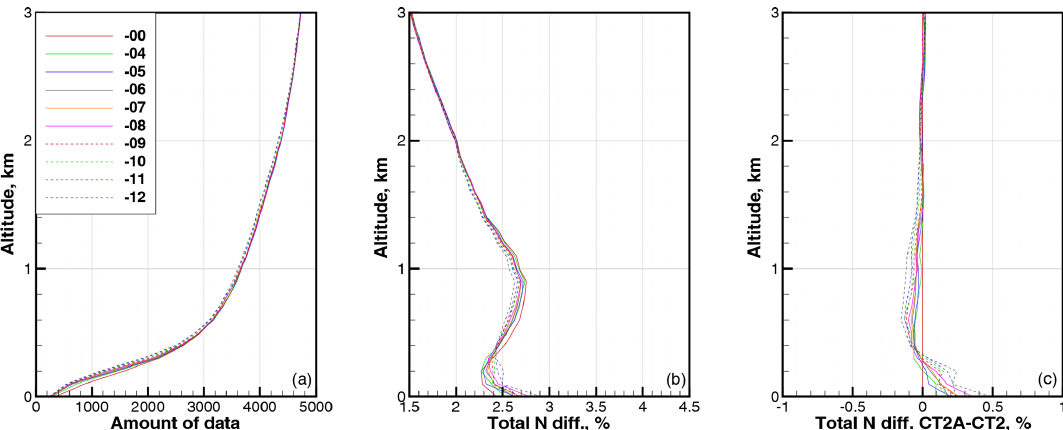
Figure 6. Statistics for latitude band 30–40 ◦ . (a) Amount of data. (b) RMS relative difference in refractivity COSMIC–ECMWF (cid:49)N CE . (c) RMS relative difference in refractivity CT2A–CT2. All are functions of the parameter β .